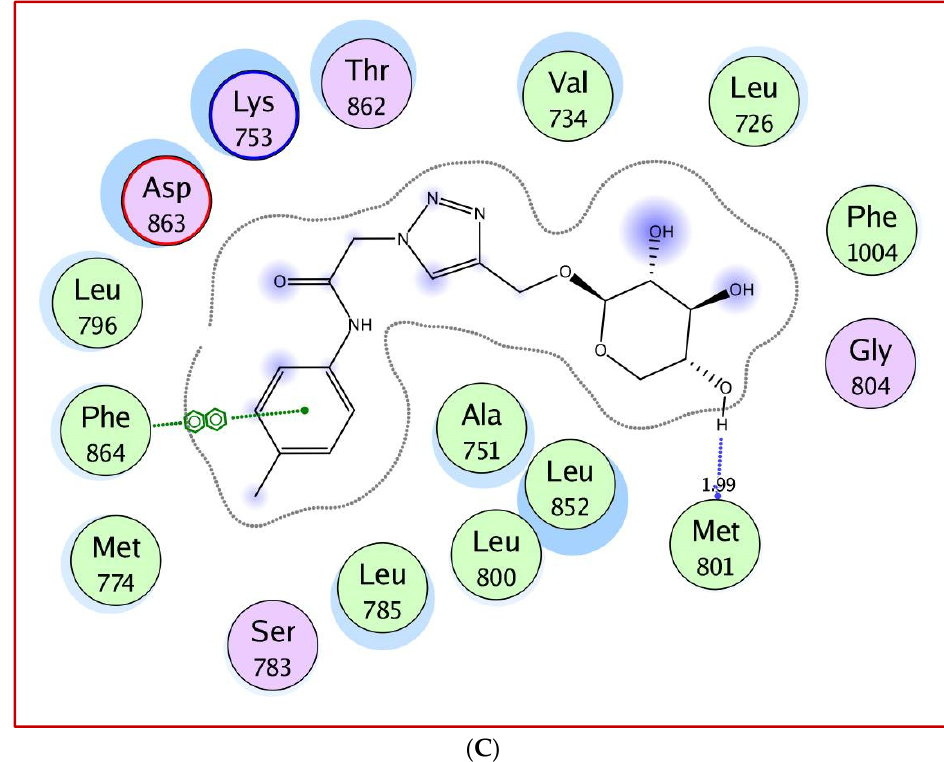
Figure 6. ( A – C ) Two-dimensional views of compounds 7 , 8 and 15 , respectively, docked in the active binding site of HER-2 (PDB ID: 3RCD) using MOE software.